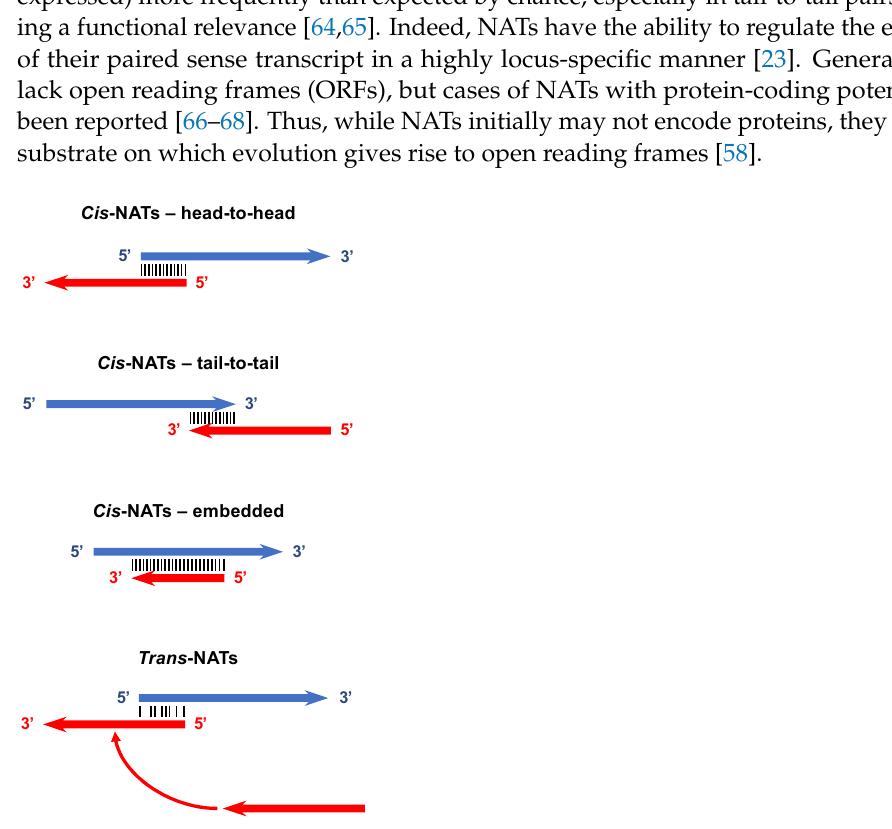
Figure 1. Types of natural antisense transcripts and overlaps with sense transcripts. NATs are divided into cis and trans . The former is expressed from the same genetic locus as their paired sense transcript. They can be organized in a head-to-head (overlap of the 5 ′ ends), tail-to-tail (overlap of the 3 ′ ends) or fully embedded (complete overlap) fashion. Trans -NATs are expressed from a different genetic locus and share only partial homology with their paired sense transcript.